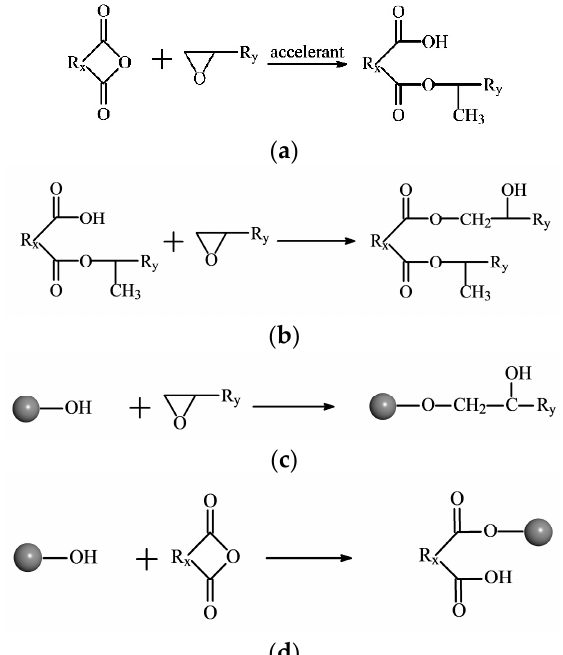
Figure 1. Mechanism of crosslinking reaction between the epoxy, acid anhydride curing agent and nano-SiO 2 . ( a ) Under the effect of trace moisture existing in the system, part of the epoxy groups open and anhydrides hydrolyze to further react with each other and produce monoester containing carboxyl; ( b ) carboxyl reacts with the epoxy groups and generates hydroxyl groups; ( c ) the hydroxyl groups on the surface of SiO 2 and the generated hydroxyl react with the epoxy groups to generate hydroxyl groups; ( d ) the hydroxyl groups on the surface of SiO 2 and the generated hydroxyl react with anhydrides to generate carboxylic acids.